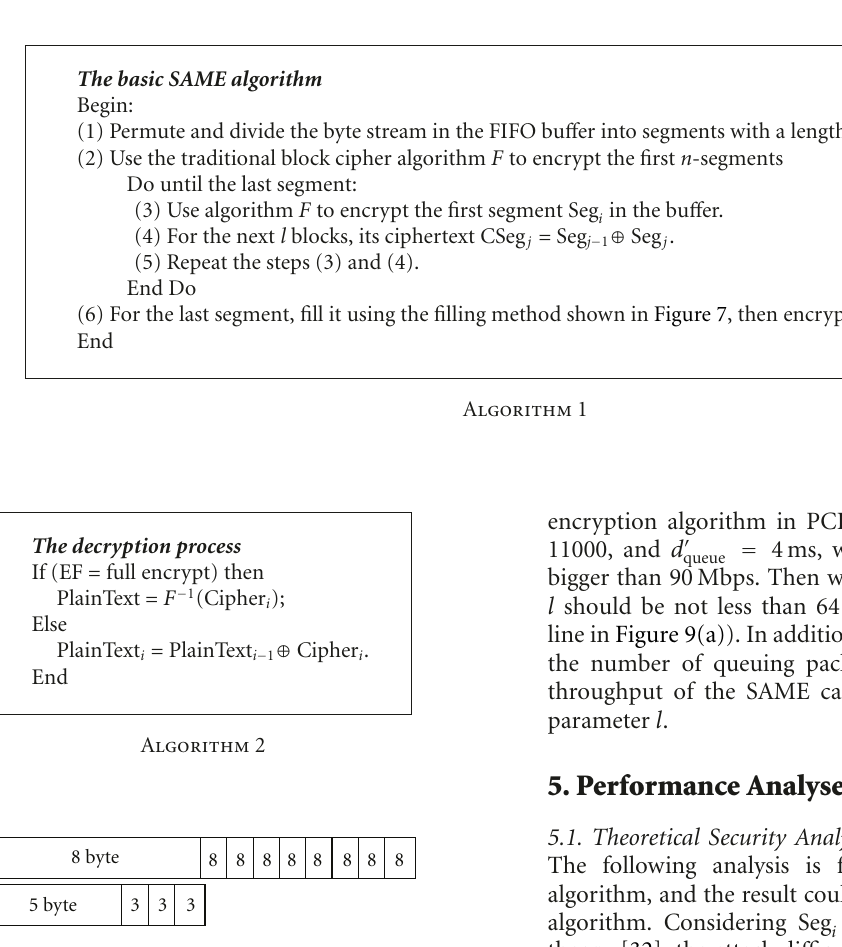
Figure 6: Speed adaptive media-data encryption (SAME) algorithm